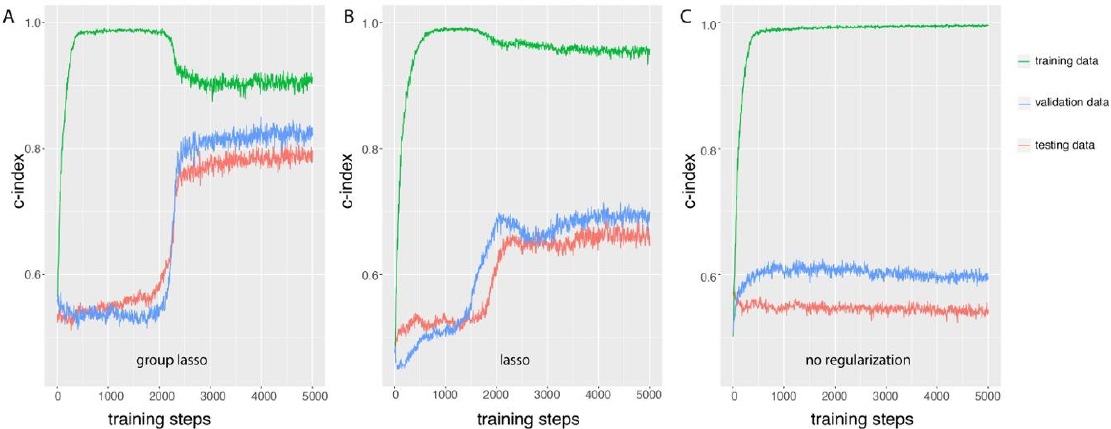
Figure 2. Group lasso overcame the overfitting of GDP training for simulated data with group information as seen in the GDP training process comparison among three different types of regularization methods: ( A ) group lasso, ( B ) lasso, and ( C ) no regularization. One training step is one round of GDP training with 50 randomized samples fed in batch as input, and the model trained after each step was evaluated on training, validation, and testing data. The biggest overfitting gap between testing data and training data was observed in the training process without regularization. Both lasso and group lasso reduced the overfitting gap, and the latter of which more significantly improved the survival prediction accuracy in the testing data (c-index approaches 0.8). For simulation details, see simulation s1 in Table S2.